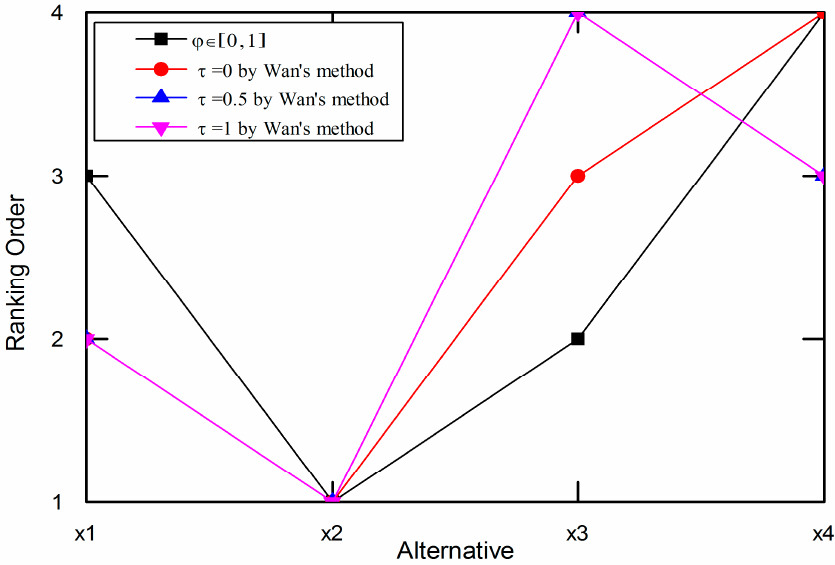
Figure 2. Ranking orders of alternative by different methods with MCI (cid:2868) = 0.1.